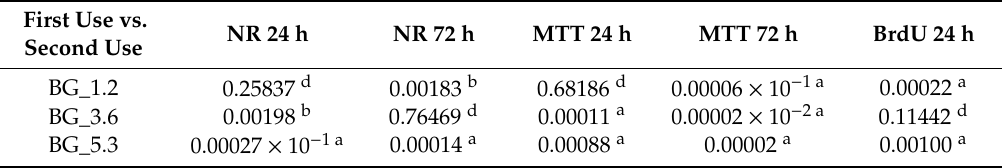
Table 2. Student’s t -test ( p values) for the first and second use results of the cytocompatibility tests applied on the